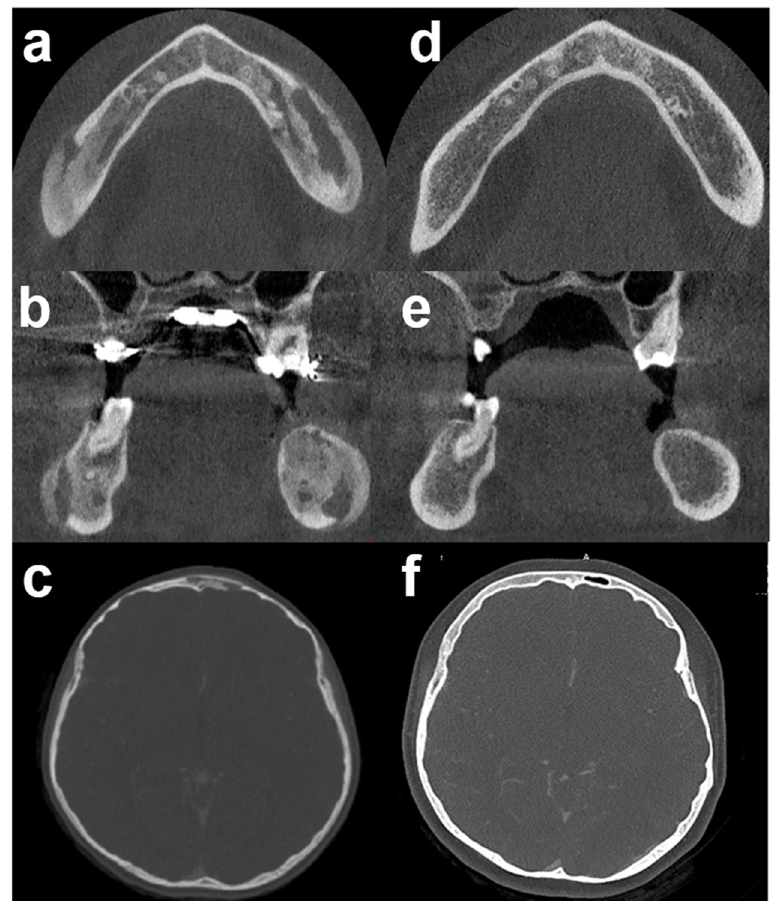
Figure 4. 3D computed tomography before and after antibiotic therapy: ( a – c ) CBCT/CT scan before antibiotic therapy. ( d – f ) The corresponding CBCT/CT scan, 6 months after antibiotic therapy demonstrated complete bone healing. Bone sclerosis and osteolysis (mixt pattern) disappeared in mandible ( d , e ) and frontal bone ( f ). CBCT: Cone Beam Computed Tomography.